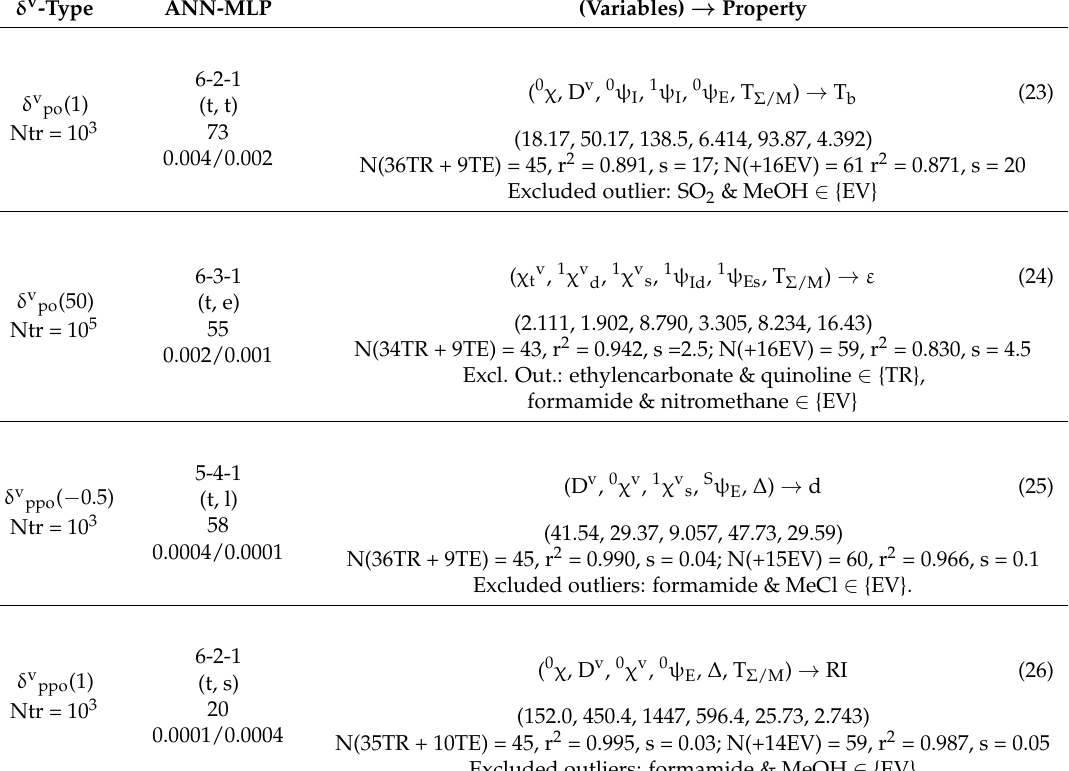
Table 6. ANN-MLP results with descriptors of Table 4 with externally imposed number of hidden neurons. The structure is similar to that in Table